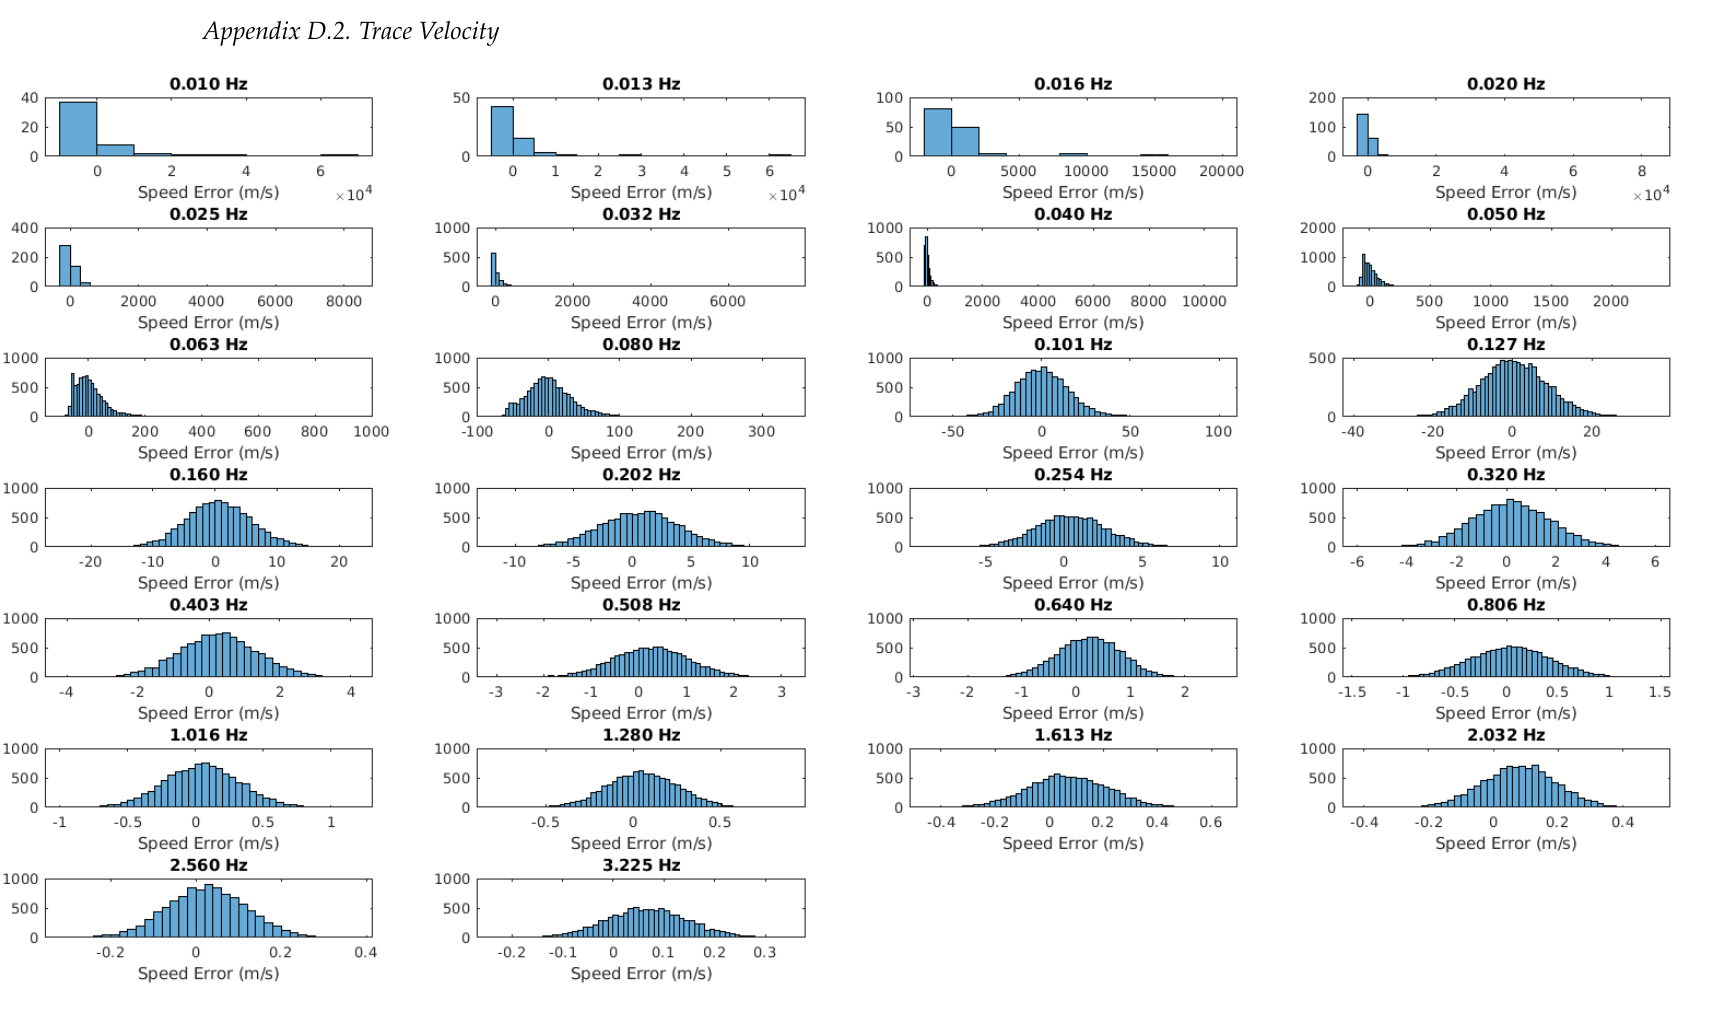
Figure A6. Trace velocity error (bias), SNR = 0 dB, M = 10 4